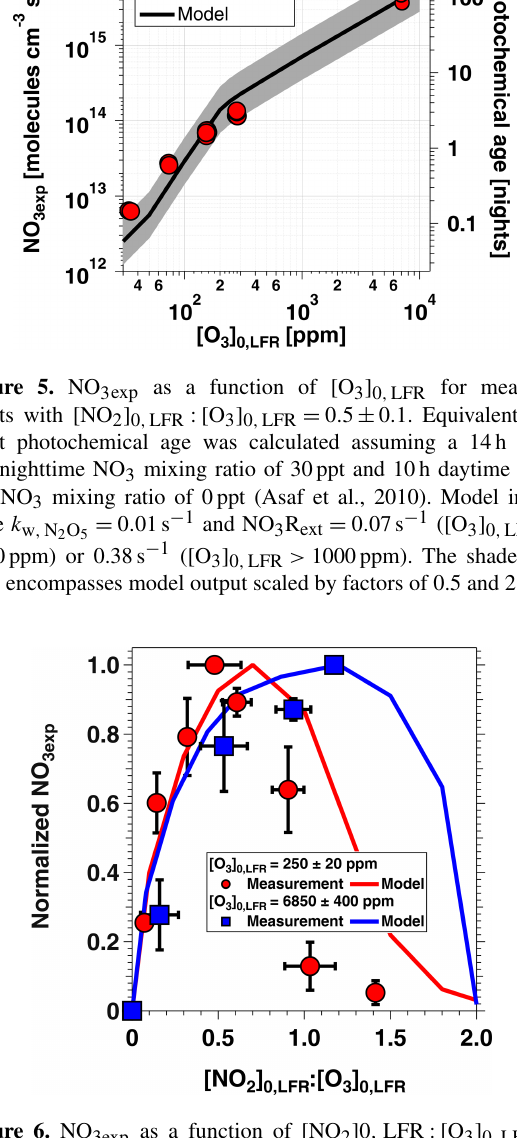
Figure 6. NO 3exp as a function of [NO 2 ]0 , LFR : [ O 3 ] 0 , LFR at fixed [O 3 ] 0 , LFR values of 250 ± 20 and 6850 ± 400ppm and RH OFR = 11% to 81%. NO 3exp values were normalized to the maximum NO 3exp value obtained at the same